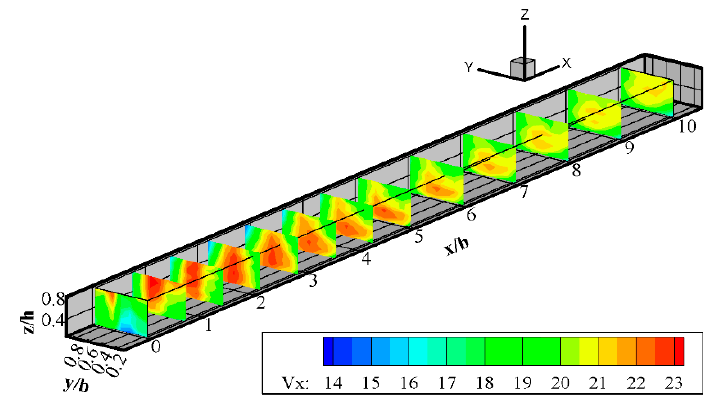
Figure 5. Contour plot showing the longitudinal flow velocities after the intersection (Qr = 0.5).